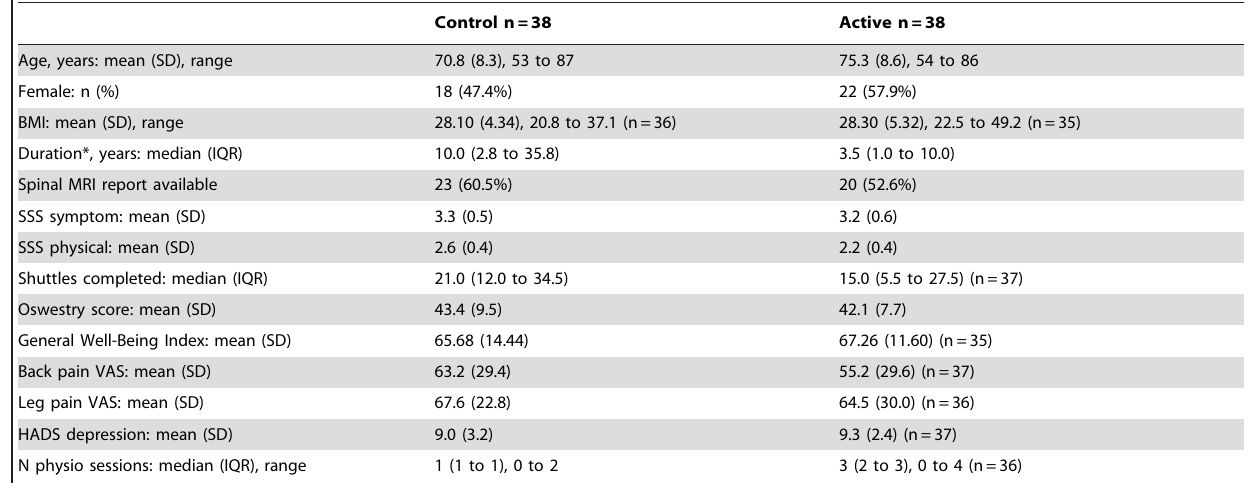
Table 2. Baseline